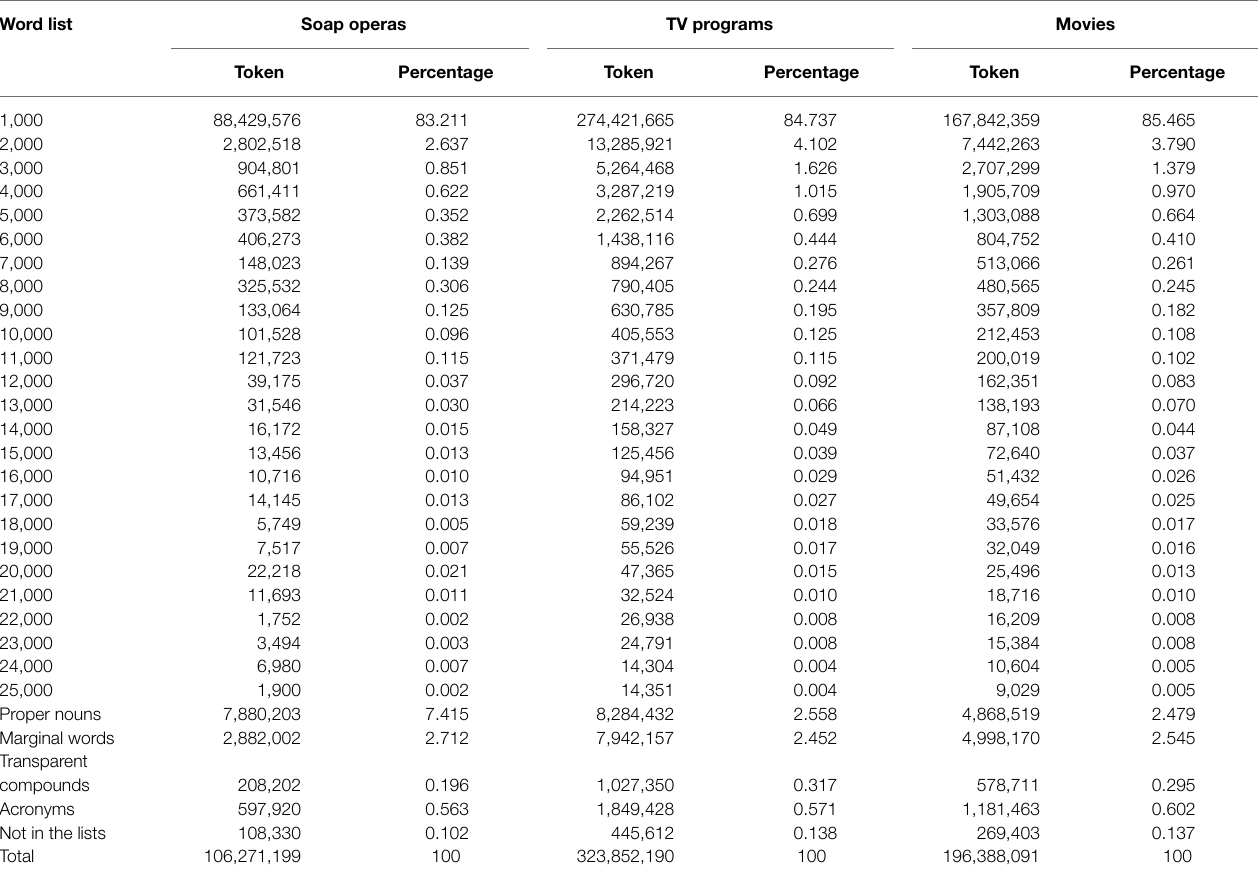
TABLE 3 | The number of tokens at each word